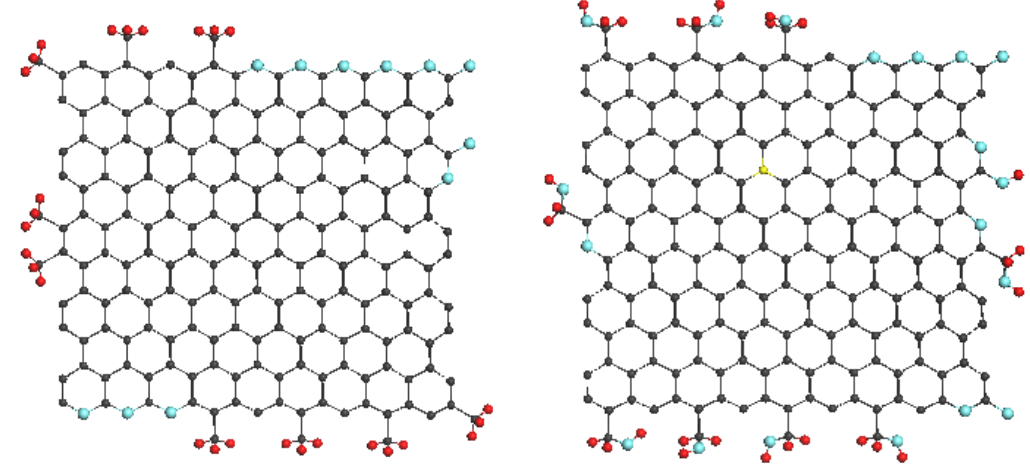
Figure 6. Molecular models of basic structure units of technical graphenes Ak-rGO ( left ) and TE-rGO ( right ). Light gray, red and black circles mark carbon, oxygen and hydrogen atoms.